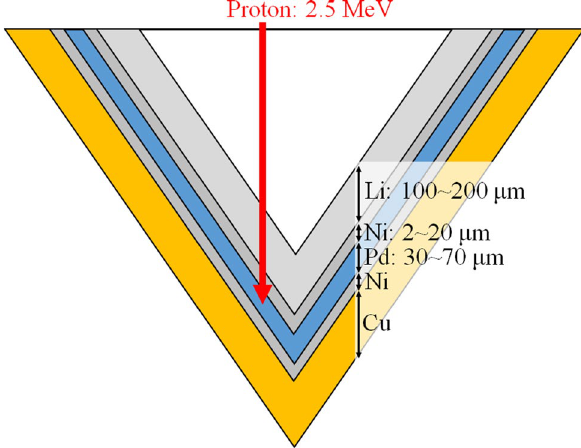
Figure 1. A schema of a cross-sectional view of the target